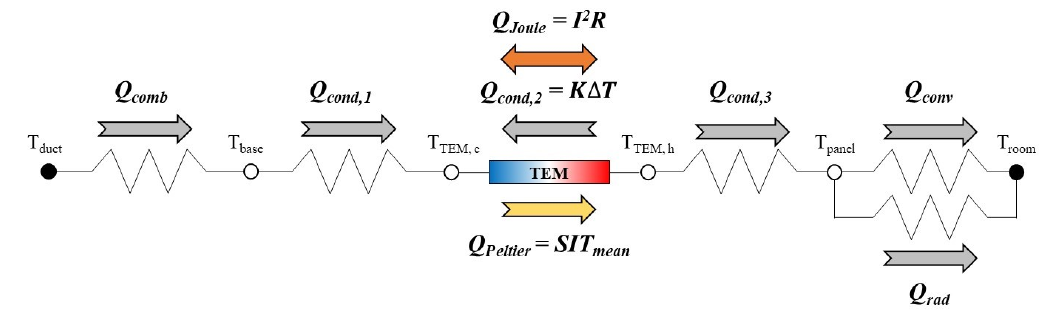
Figure 3. Steady-state heat flows through the TEM in the heating mode of the TERP.